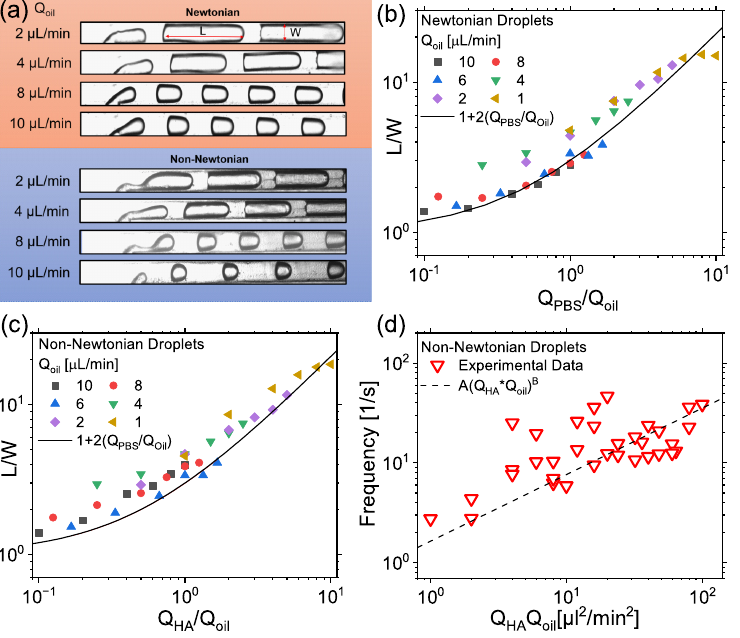
Figure 2. Droplet generation formation and scaling in a T − junction microfluidic device. ( a ) Exper- imental snapshots of droplet generation at various continuous phase (oil) flow rates Q oil . For the Newtonian case, phosphate buffer saline (PBS) is employed as the dispersed phase. For the non- Newtonian case, hyaluronic acid (HA) at a mass concentration of 0.1 wt% is used as dispersed phase. Satellite droplet formation is only observed in the non-Newtonian case. The volumetric flow rate of the dispersed phase is 8 µ L/min in both cases. ( b , c ) Normalised droplet size L / W , where L is the droplet length and W = 100 µ m is the channel width (see experimental snapshot in ( a )), as a function of the ratio Q PBS / Q oil for the Newtonian droplets ( b ) and Q HA / Q oil for the non-Newtonian droplets ( c ). Q PBS and Q HA are the flow rates of PBS and HA, respectively, while Q oil is the flow rate of the mineral oil. The solid line in ( b , c ) is L / W = 1 + 2 ( Q PBS / Q oil ) , meaning that the non-Newtonian data in ( c ) collapse on the master curve for Newtonian droplets. ( d ) Frequency of non-Newtonian droplet generation as a function of the product Q HA Q oil . Data points collapse on the master curve f drop = A ( Q HA × Q oil ) B with A = 1.64 ± 0.18 and B = 2/3. The parameter A was obtained by fitting the entire data set with flow rate values in the units of µ L/min, while B was fixed to B = 2/3 according to the previously introduced by Shahrivar and Del Giudice [27] for xanthan gum